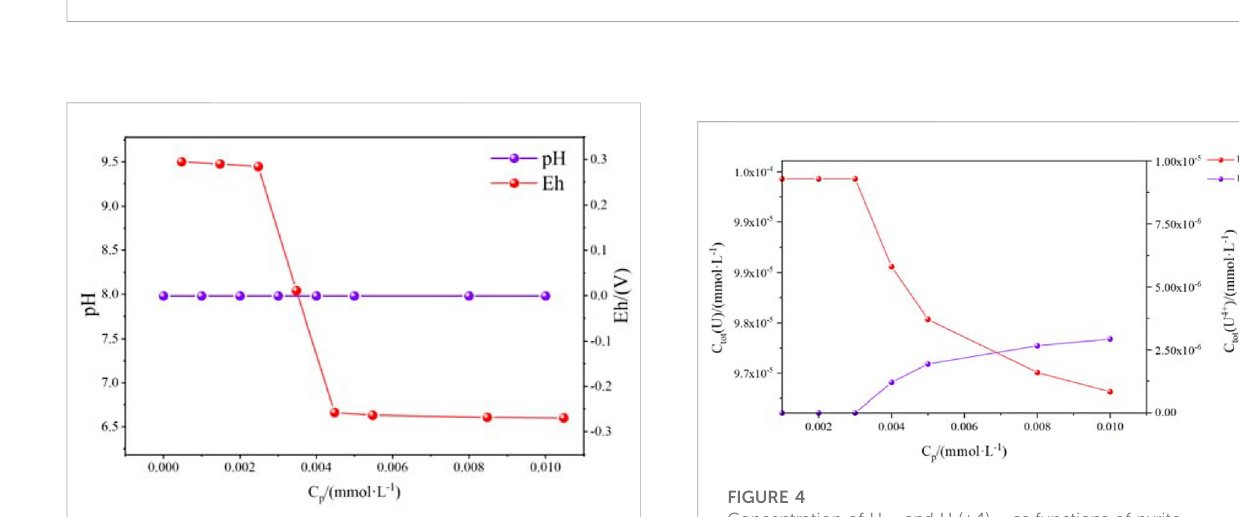
FIGURE 2 Saturation index evolution of the precipitation of U( Ⅳ ) as a function of pyrite (A) and magnetite (B) .